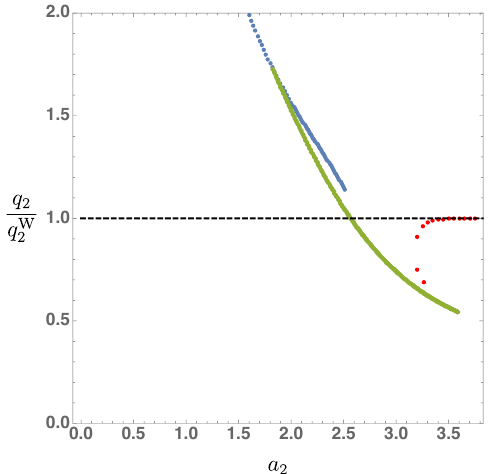
p 3: when increasing a 2 , the blue